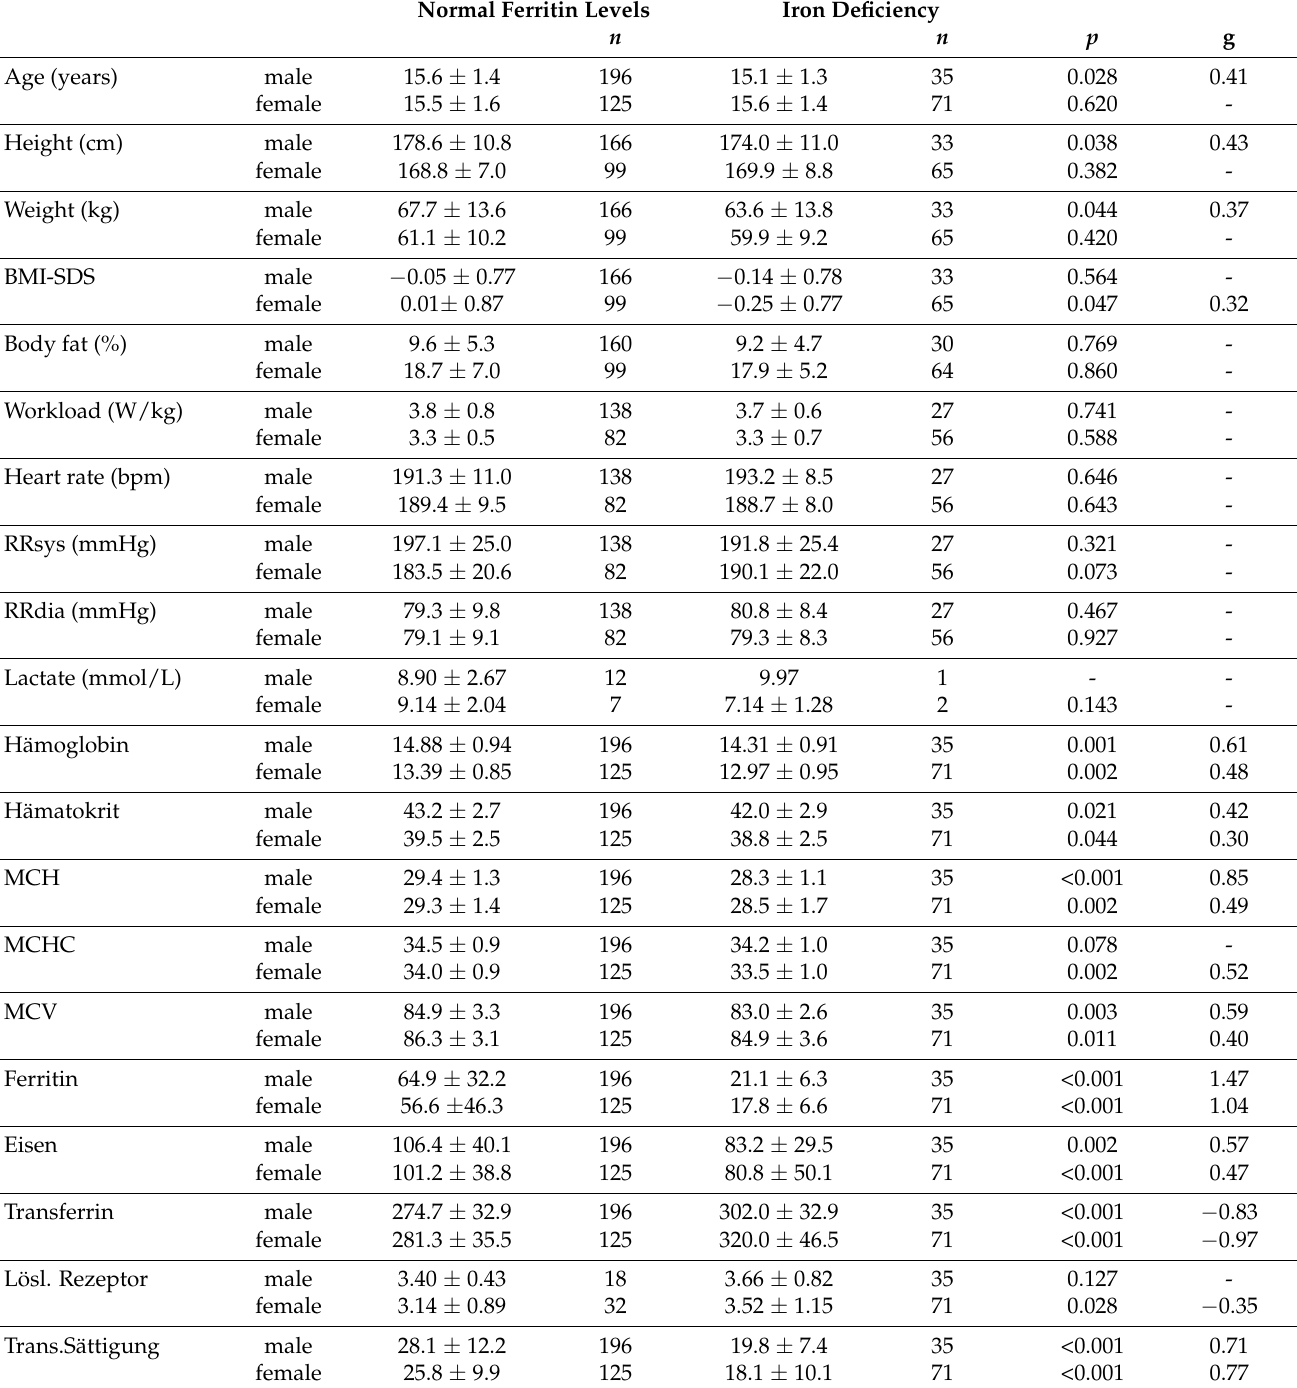
Table 3. Subject characteristics of adolescents (age < 18